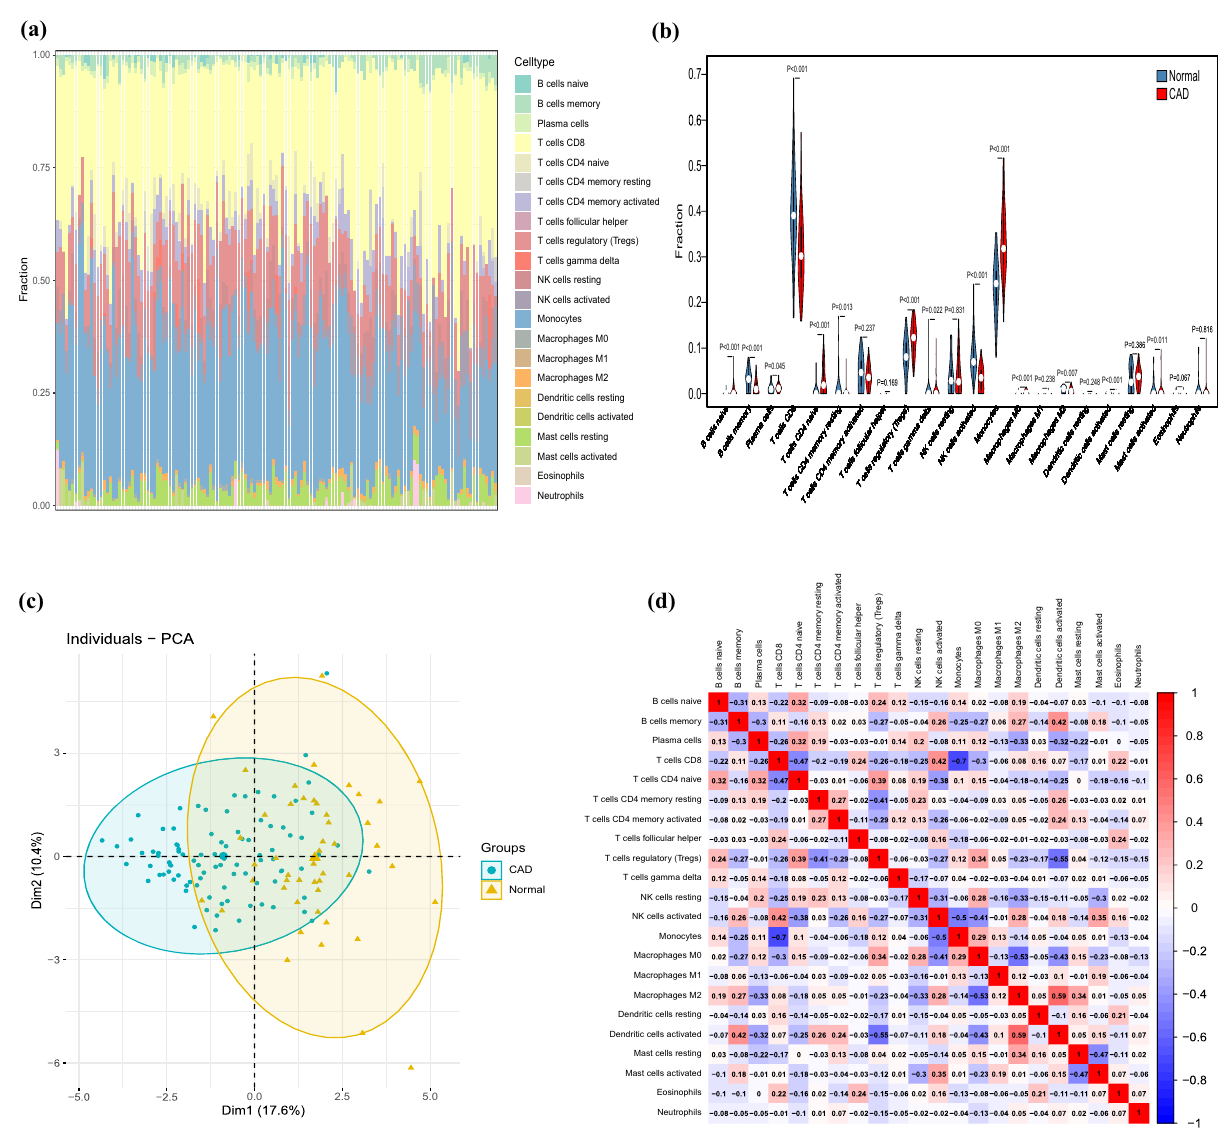
Figure 6: Evaluation and visualization of immune cell in fi ltration by CIBERSORT algorithm. ( a ) Immune cell types and ratios of CAD groups. ( b ) Violin plot comparing immune cell compositions between CAD groups and normal groups. ( c ) PCA for immune cell compositions between CAD groups and normal groups. ( d ) Pearson correlation heatmap between in fi ltrating immune cell